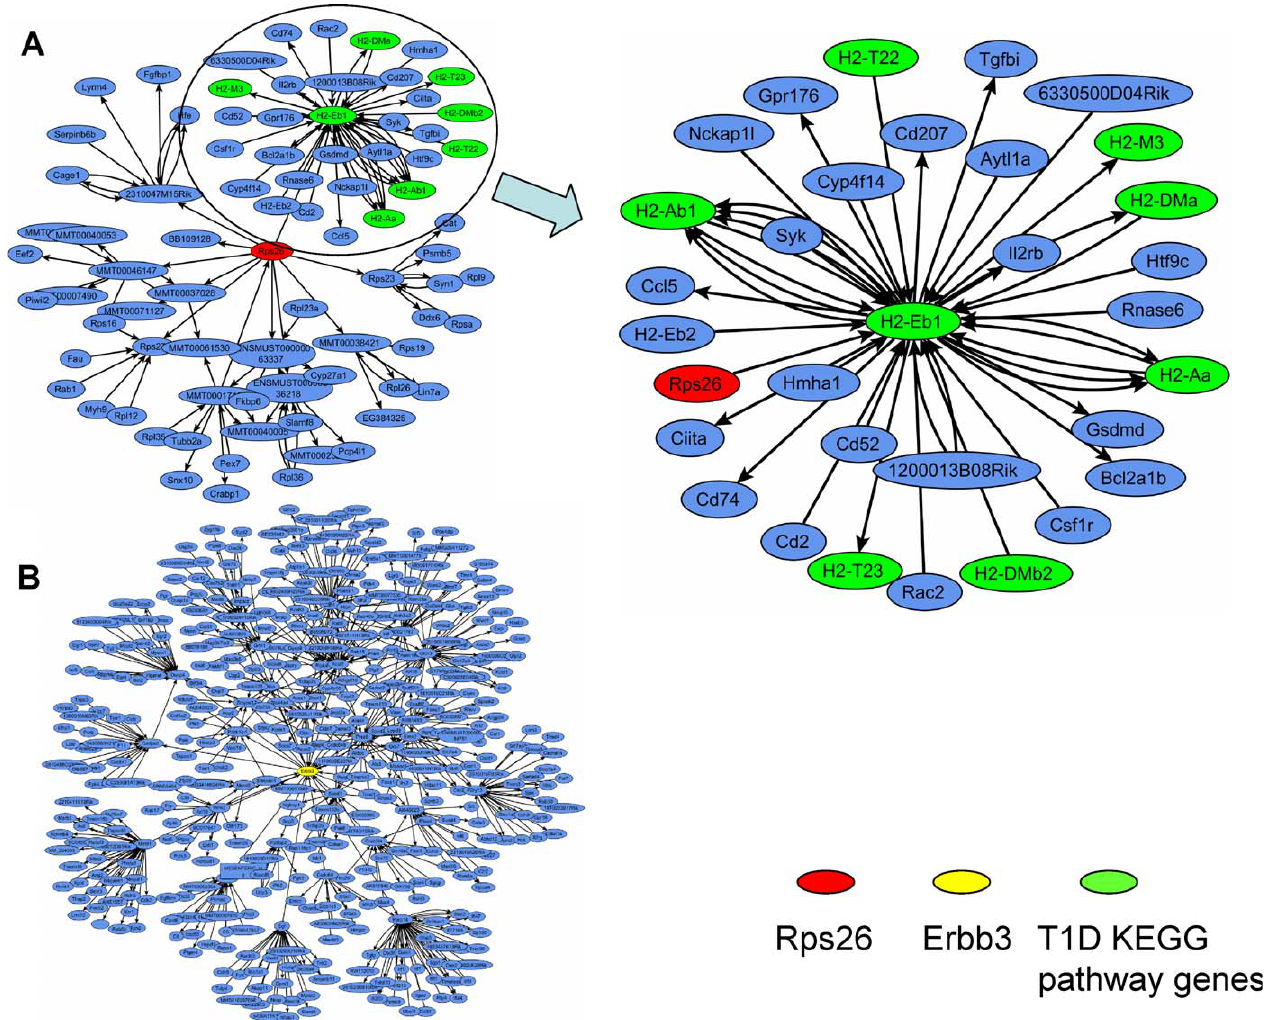
Figure 1. Local Networks for Rps26 and Erbb3 Derived from Causal, Probabilistic Whole-Gene Networks Constructed from the Liver, Adipose, Muscle, and Brain Gene Expression Data Generated from the BXH/wt and BXC Mouse Crosses (A) The Rps26 subnetwork includes a number of known T1D associated genes (green nodes), and RPS26 in this subnetwork is directly linked to H2-Eb1 , a mouse ortholog of HLA-DRB1 , a previously identified T1D susceptibility gene that is also strongly associated with a cis eSNP in the HLC (Table 2). The known T1D genes annotated by the Gene Ontology are significantly enriched in this subnetwork (Table 3). (B) The Erbb3 subnetwork is not associated with any pathways known or predicted to be involved in T1D.